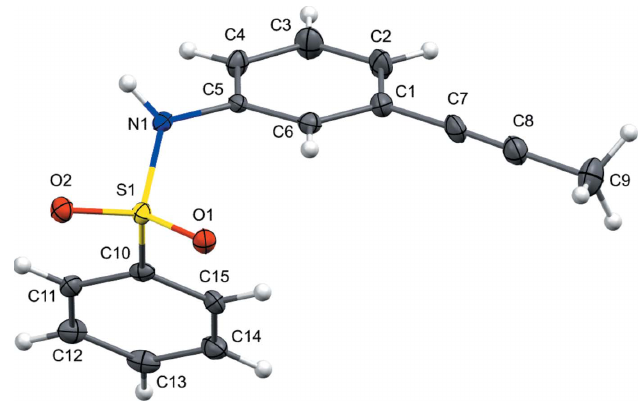
Figure 1 The title molecule with 50% probability ellipsoids.